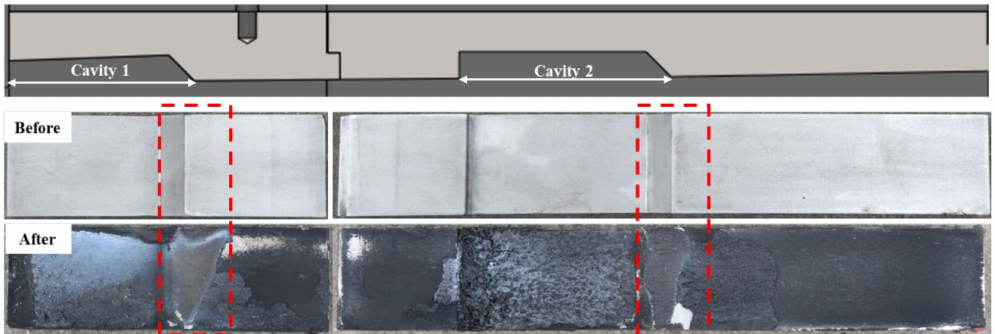
Figure 15. Comparison of the cavity before and after the